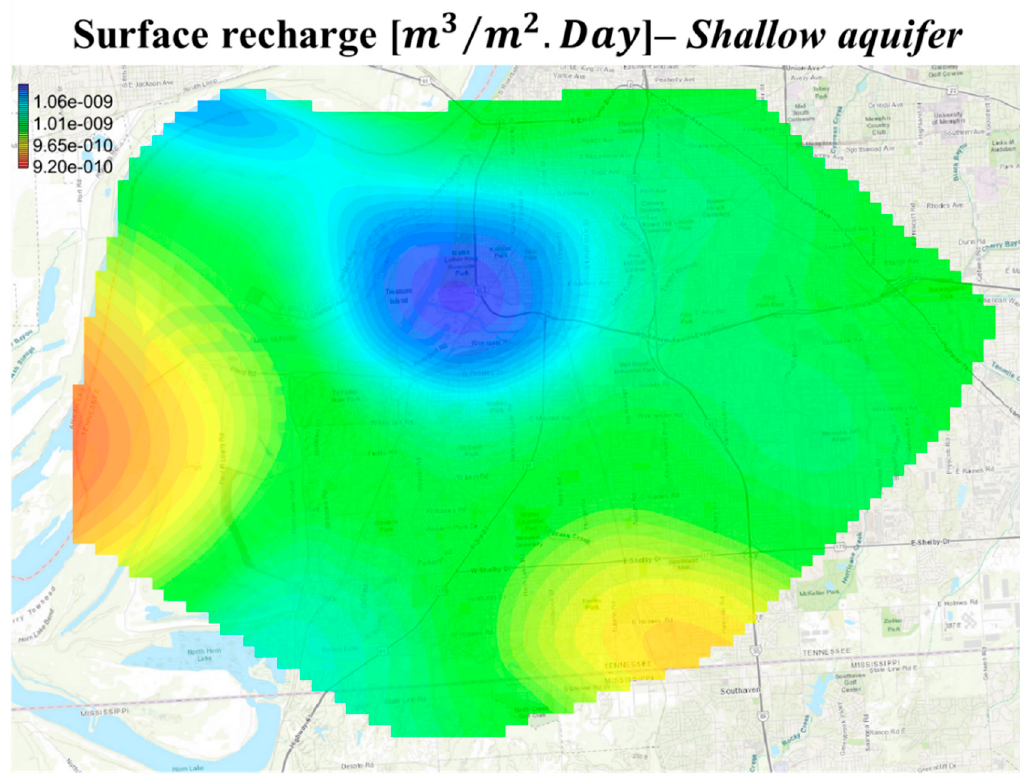
Figure A4. The calibrated surface recharge to the Shallow aquifer.